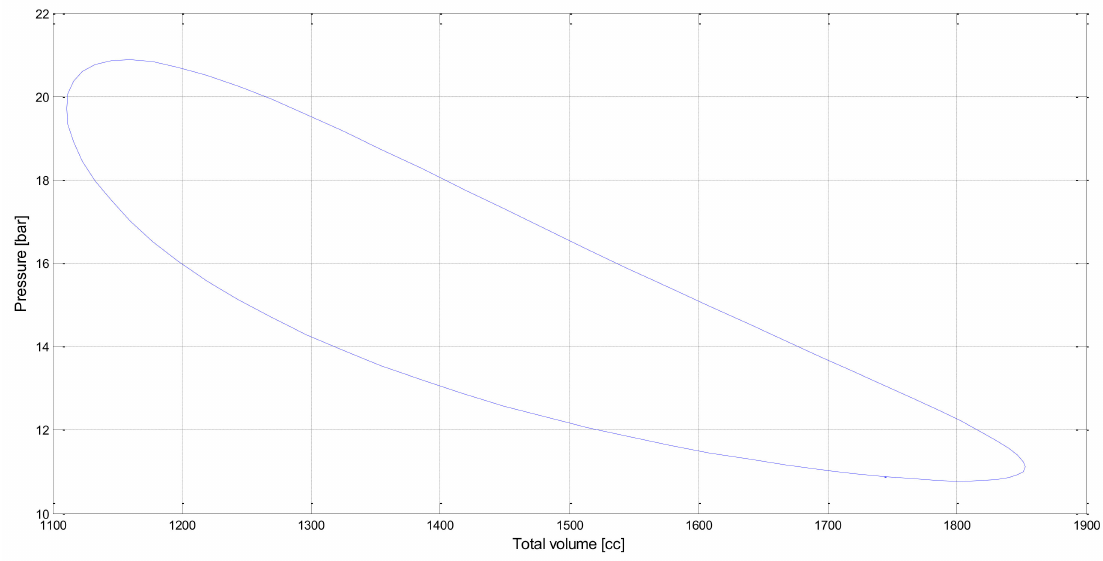
Figure 8. Pressure-volume (P-V) diagram of the isothermal